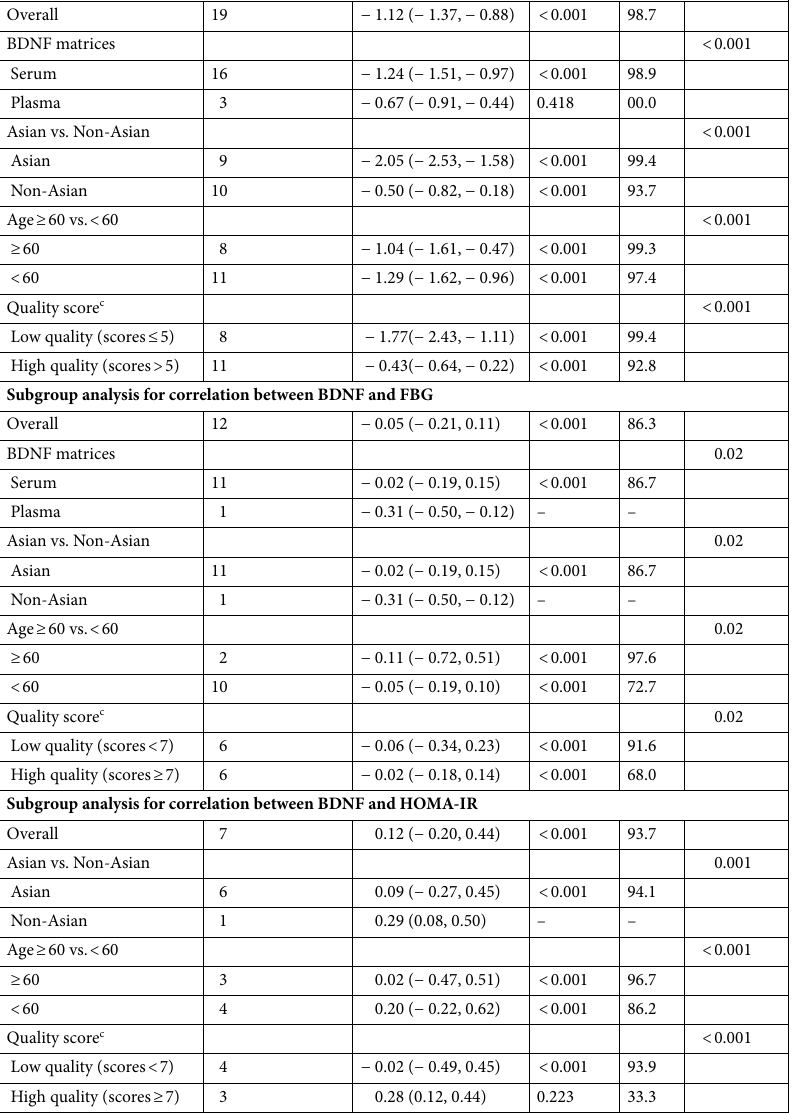
Table 2. Findings from subgroup analysis of mean difference of serum BDNF levels in cases with T2D or glycemic disorders vs. healthy controls as well as correlation between serum BDNF levels and glycemic parameters. a P for heterogeneity, within subgroup. b P for heterogeneity, between subgroups. c Quality Scores were according to Newcastle–Ottawa